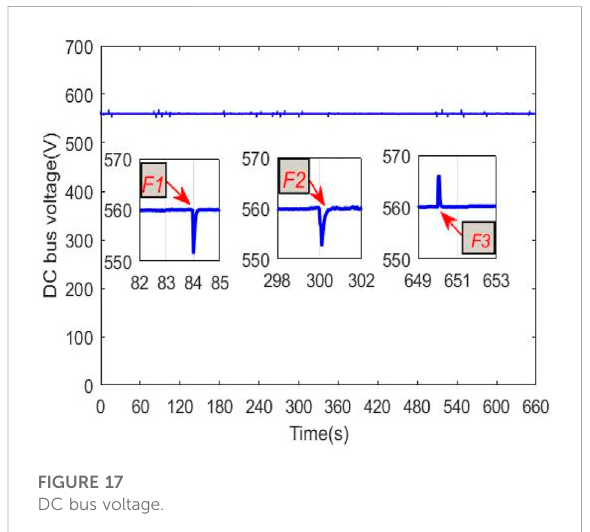
FIGURE 17 DC bus voltage.